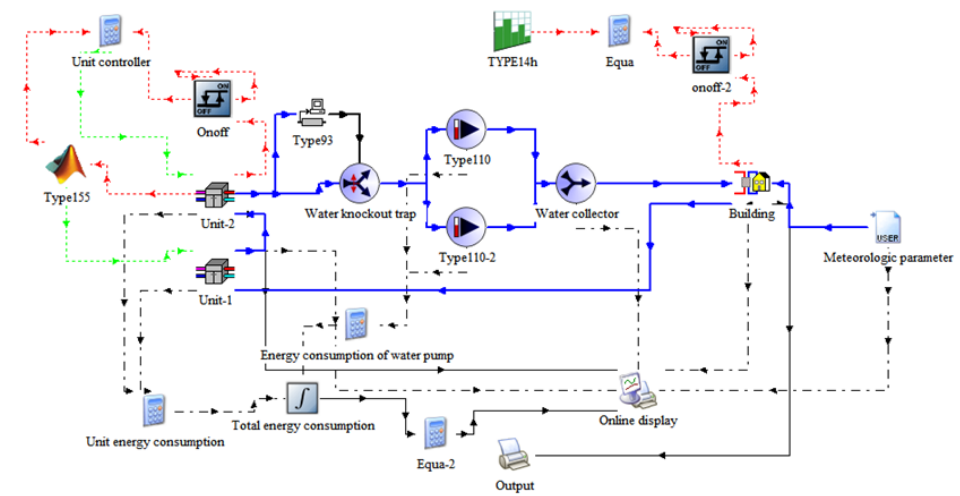
Figure 6. TRNSYS simulation platform.